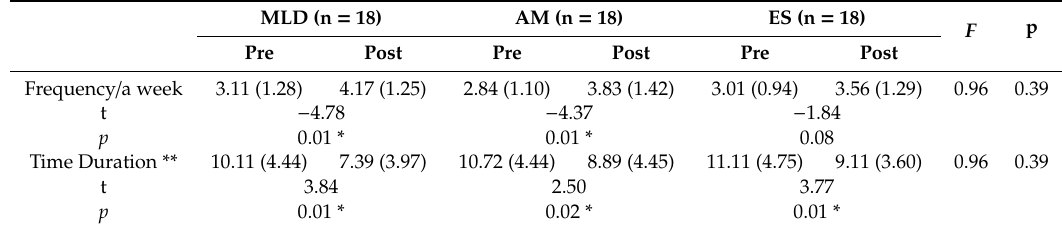
Table 6. Bowel movement frequency and time–duration t-test and ANOVA analyses (N =